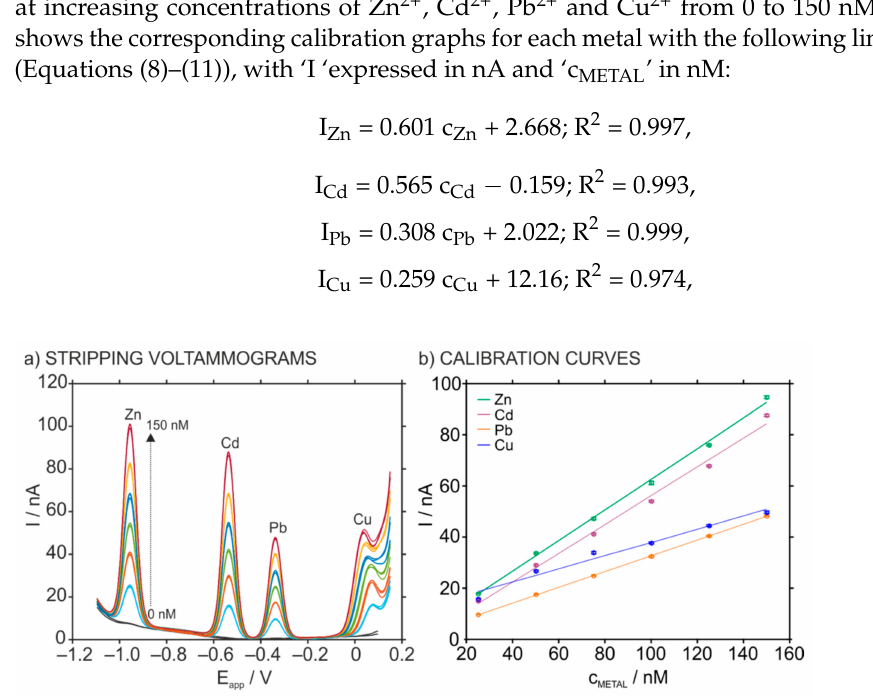
Figure 6. ( a ) Square-wave anodic stripping voltammograms for the simultaneous determination of increasing concentrations of Zn 2+ , Cd 2+ , Pb 2+ , and Cu 2+ . ( b ) Corresponding calibration graphs after background